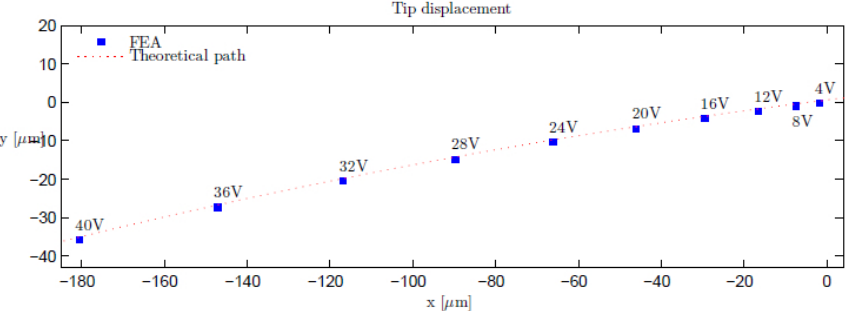
Figure 5. Tip displacements (point P ) for different values of the applied voltage and the theoretical path of point P (dotted